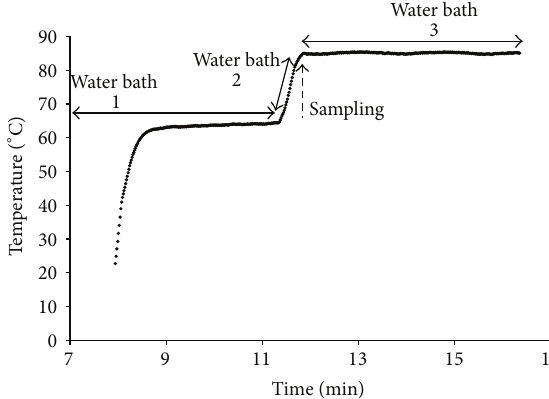
Figure 1: Imposed temperature profiles (in the three water baths) to carry out thermal denaturation at a constant holding temperature.